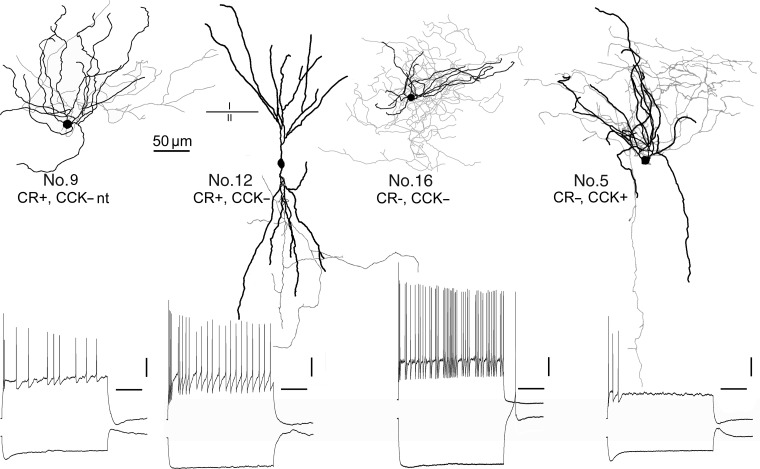
COUP-TFII-immunopositive interneurons in layer II, showing different dendritic (black) and axonal (gray) arborizations, and responses to depolarizing and hyperpolarizing current injections at resting membrane potential (lower row). The neurons showed highly variable firing patterns, spike frequency adaptation and spike amplitude accommodation, and sag and depolarizing hump in response to hyperpolarization. Cells were visualized by intracellular biocytin injection following whole-cell recording. All cells were tested for CR immunoreactivity; Nos 9 and 12 were immunopositive; the other 2 neurons were immunonegative. Cells 12, 16, and 5 were tested for CCK and only cell 5 was immunopositive. Scale bars: drawings, 50 µm; recordings, 20 mV, 200 ms.